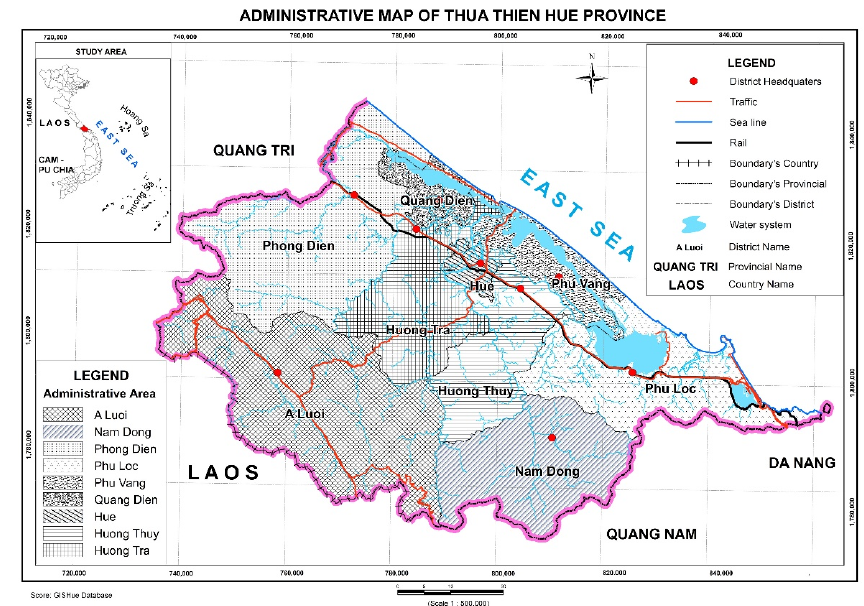
Figure 1. Administrative map of Thua Thien Hue